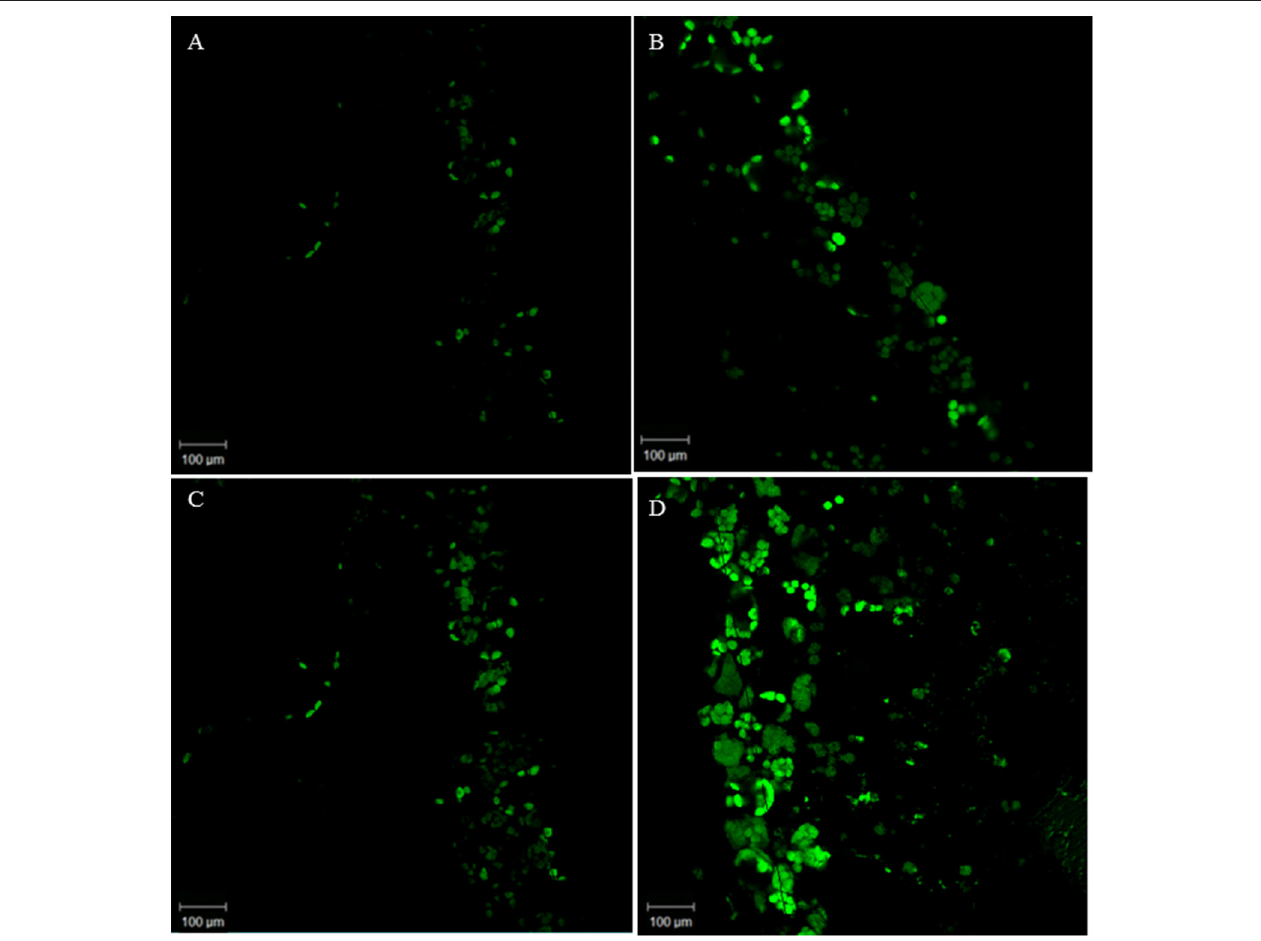
FIGURE 1 | Representative images illustrating the confocal laser immunofluorescent detection of NO in Pistia stratiotes leaves. NO was detected by its bright green fluorescence after incubation with DAF-2DA. Control plants with DAF-2DA (A) ; Plants treated with SNP and DAF-2DA (B) ; Plants exposed to arsenic and incubated with DAF-2DA (C) ; Plants exposed to arsenic + SNP and incubated with DAF-2DA (D) .